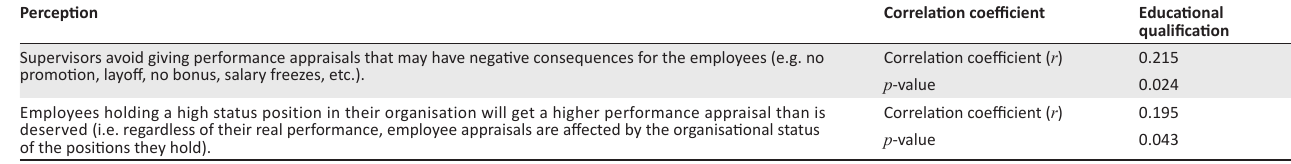
TABLE 1: Spearman’s rank correlation between educational qualification and perception of employees about performance appraisals. Perception